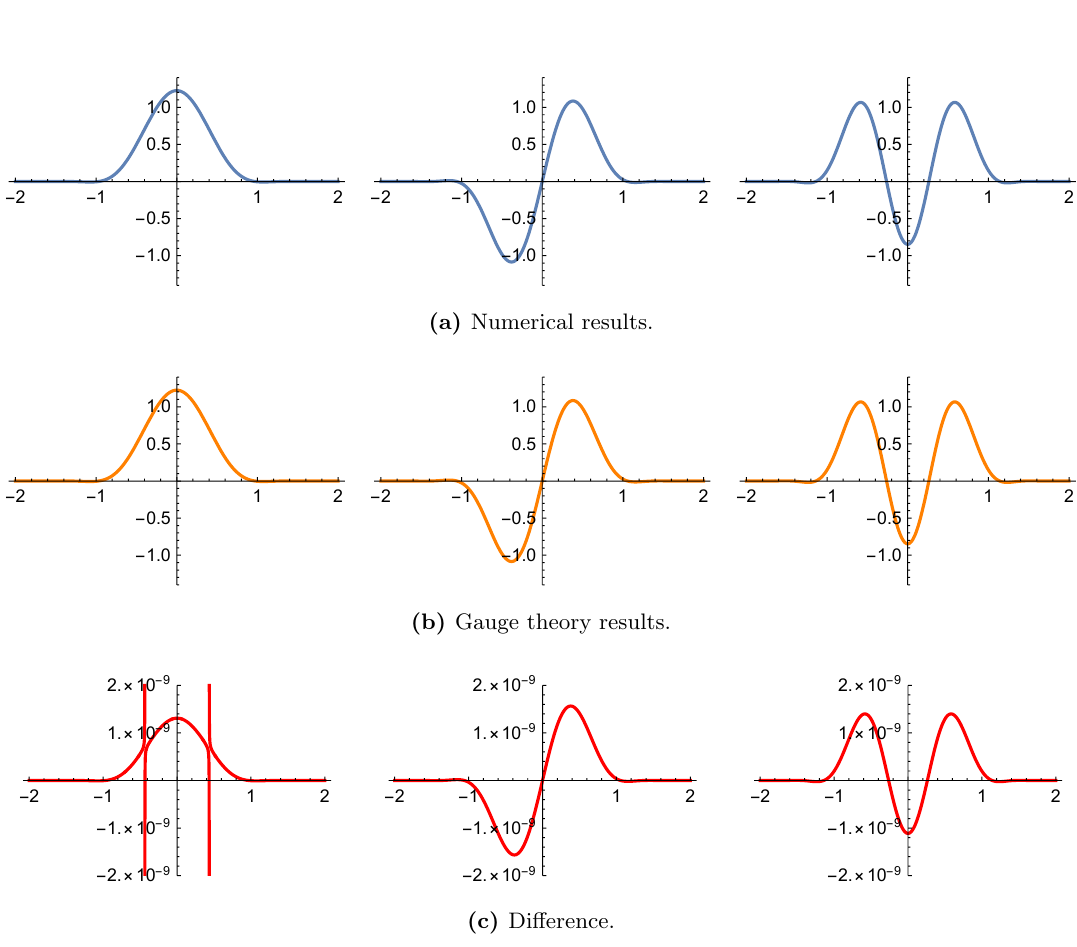
Figure 14. Level n = 0 ; 1 ; 2 gauge theory 2-particle Baxter solution q ( (cid:27) ) for ! 1 = 1 p , ! 2 = 1, m 0 = (cid:0) ln3 2 (cid:25) 2